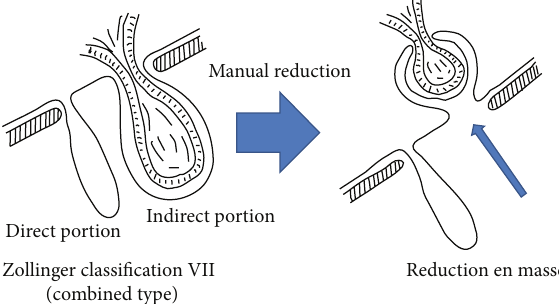
Figure 1: Our case illustration. It is a recurrent left inguinal hernia of Zollinger classification type VII (combined type). The indirect hernia portion includes an incarcerated small intestine. The indirect portion of reduction en masse occurred by manual reduction and the remaining portion of the direct hernia was treated surgically at